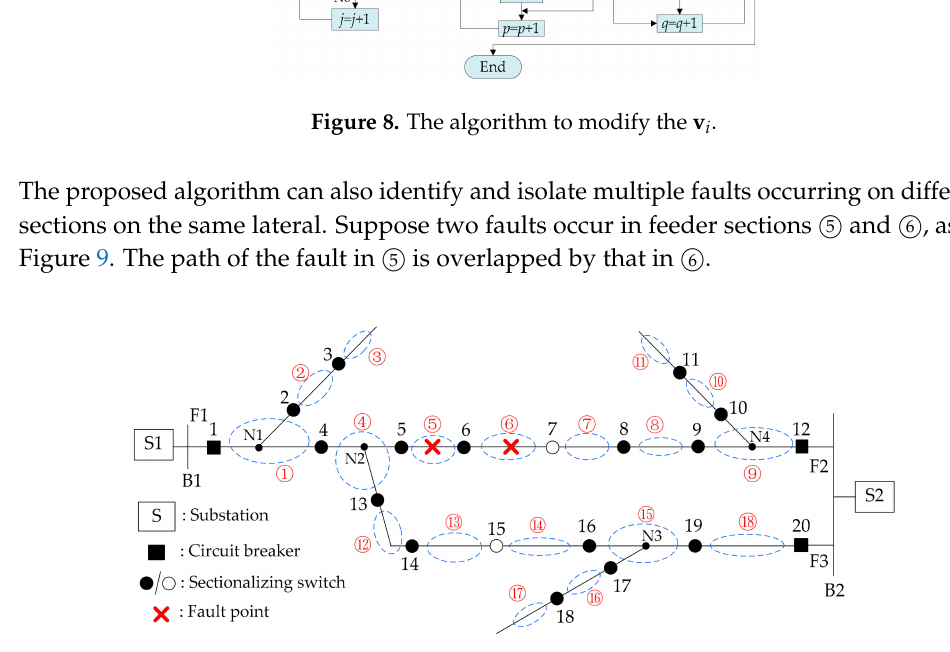
Figure 9. Multiple faults occur in the same lateral but different